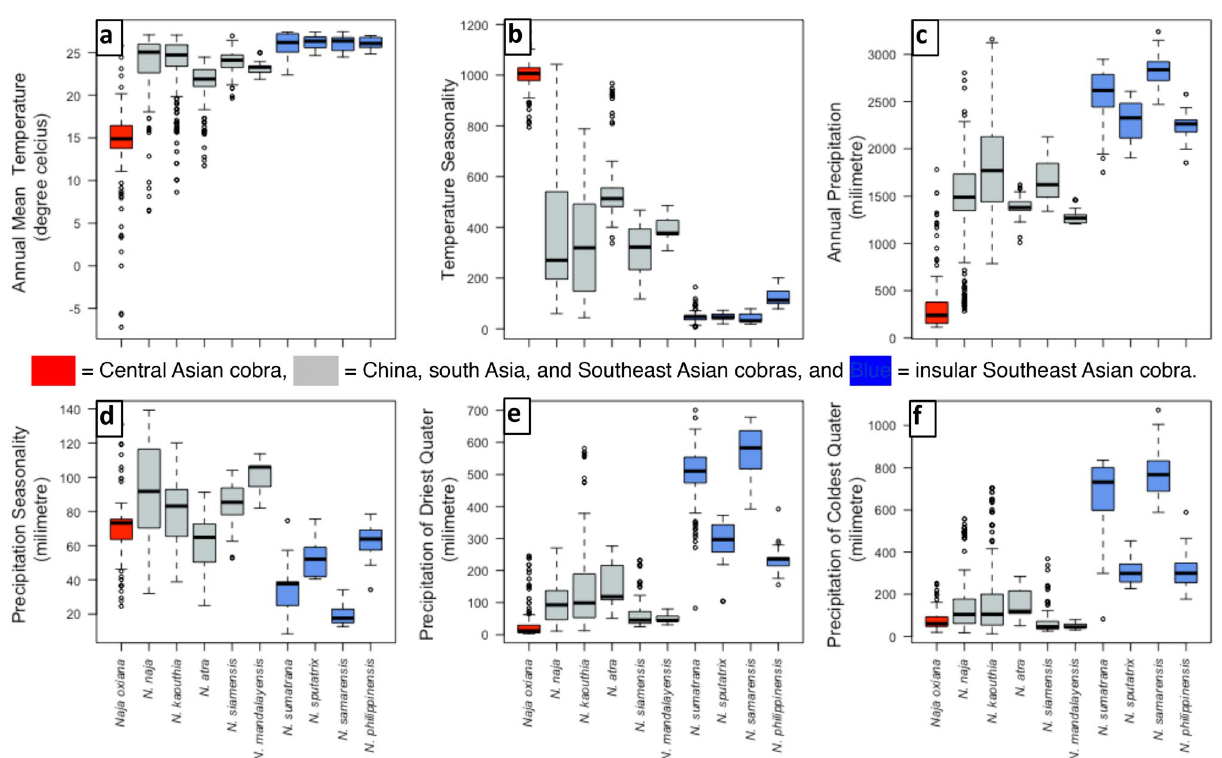
Figure 5. Six bioclim variables explain 74% of the cumulative variance to differentiate the three major climatic niche of Asiatic cobras. ( a ) Annual mean temperature, ( b ) temperature seasonality, ( c ) annual precipitation, ( d ) precipitation seasonality, ( e ) precipitation of driest quarter, ( f ) precipitation of coldest